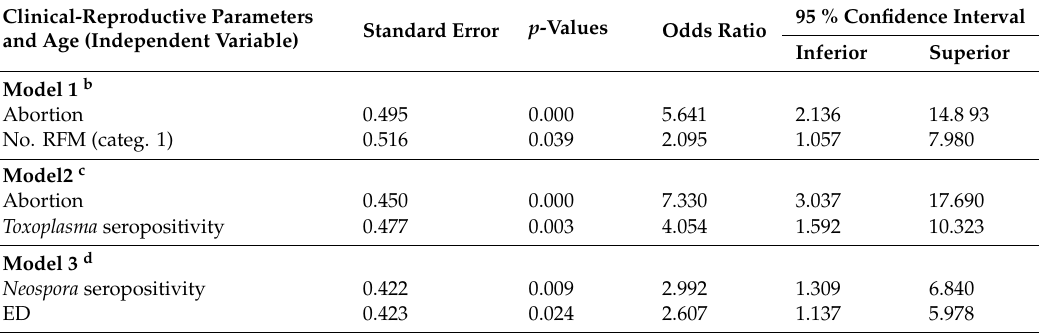
Table 3. Results of logistic regression model a